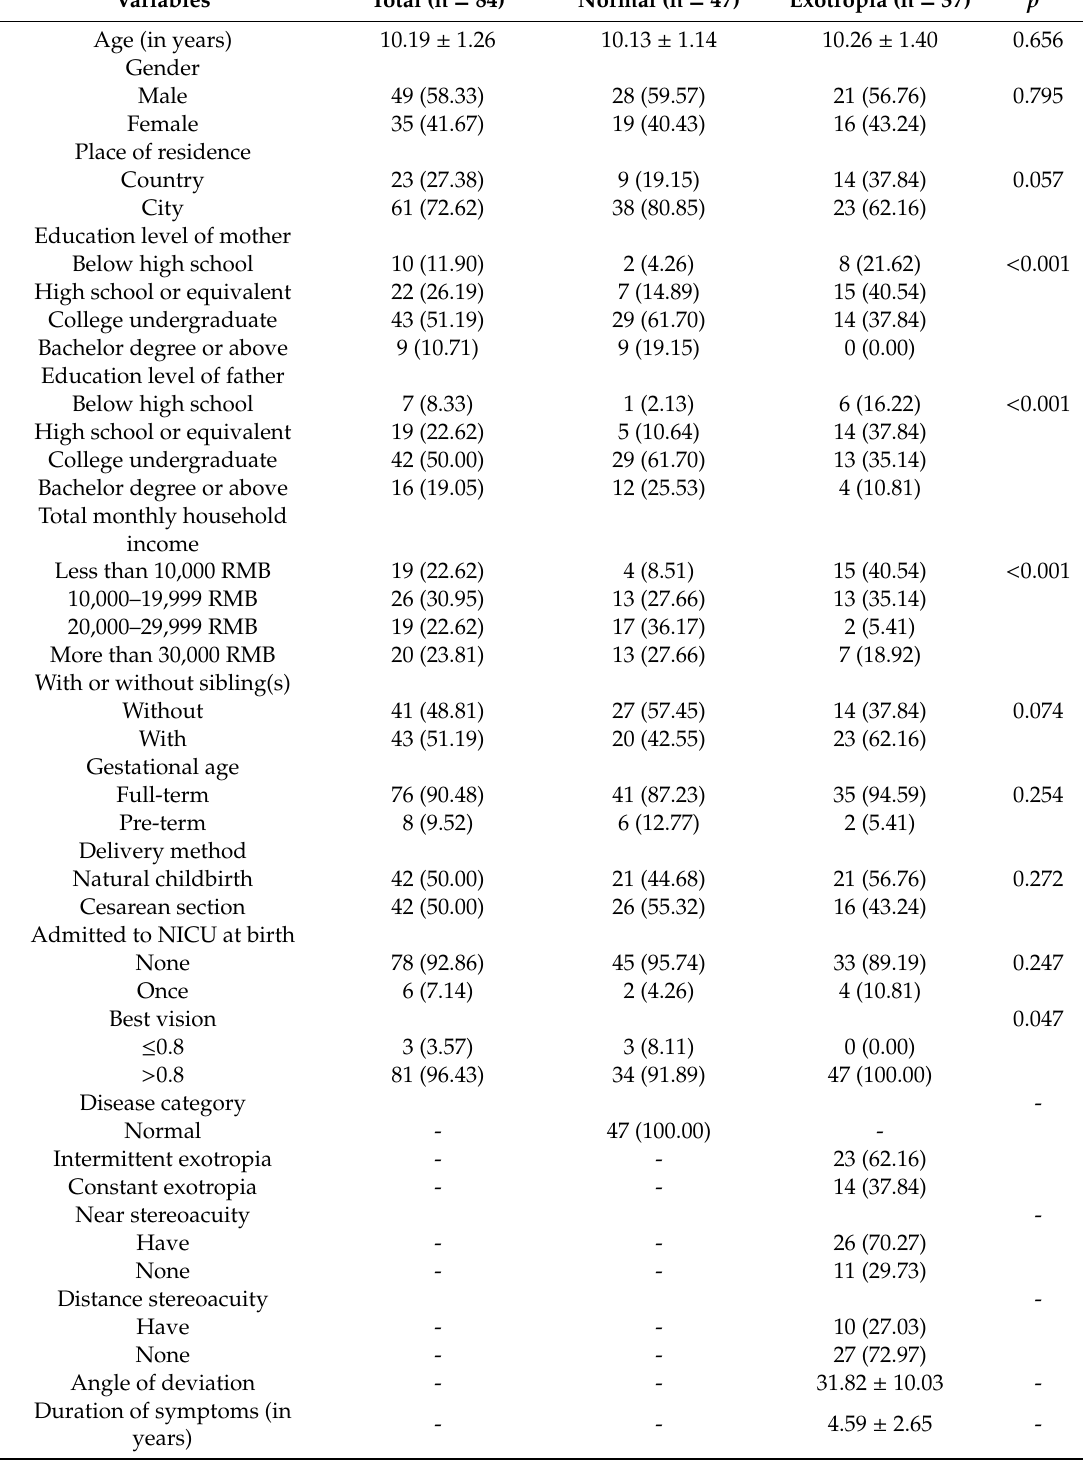
Table 1. Demographic and baseline clinical